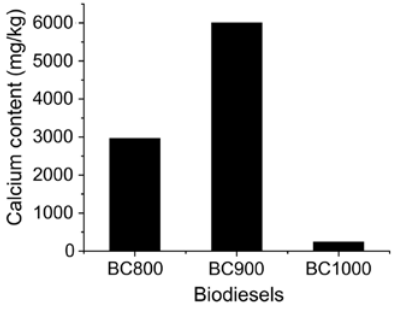
Figure 9: Calcium content in crude biodiesel.